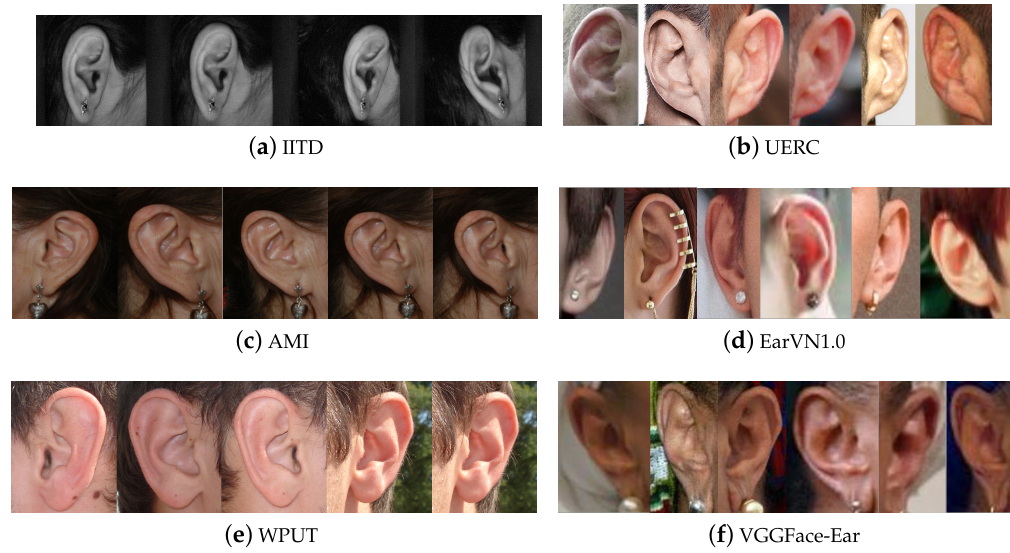
Figure 3. Ear datasets samples. The left column group is constrained and semiconstrained datasets (IITD, AMI, WPUT), while the right column group shows samples from unconstrained datasets (UERC, EarVN1.0, VGGFace-Ear). All samples belong to the same individual. Thus, it can be noticed the variability among samples from the same class.